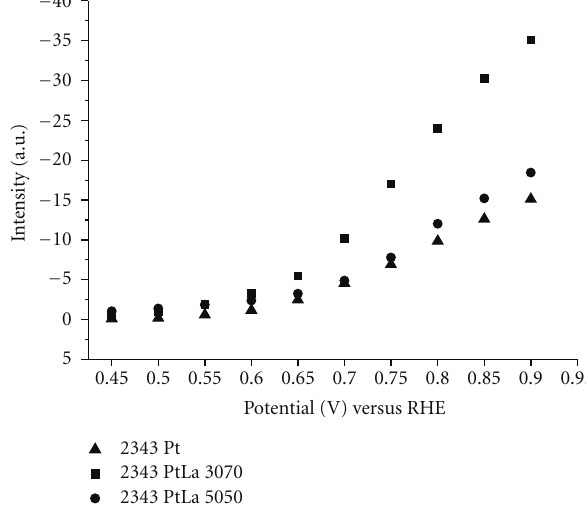
Figure 5: Potential dependence of the integrated band intensity (2343cm − 1 ) from Figure 3 corresponding to CO 2 , for Pt/C, PtLa/C (50:50), and PtLa/C (30:70)